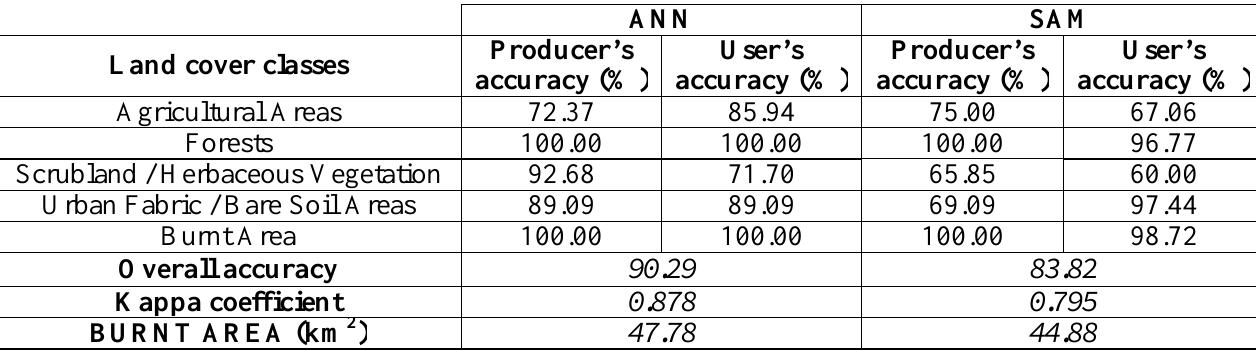
Table 2. Summarized classification results from the implementation of the SAM and ANN classifiers to the Landsat TM post-fire imagery.